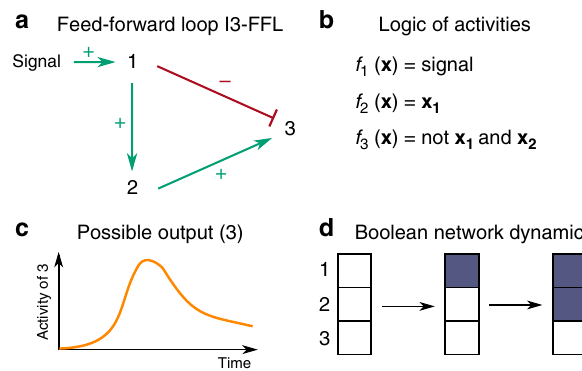
Fig. 1 Boolean modeling of the incoherent feed-forward loop of type 3 (I3-FFL). a the I3-FFL network and ( b ) its associated Boolean logic for nodes activities; f 1,2,3 ( x ) are the Boolean functions used to compute the next value of each node from a given con fi guration x of the network, which is here a binary vector specifying the current value of each node, x i referring to the Boolean value of node i . Whereas theoretical and experimental studies showed that starting from all nodes being inactive, an activation of the output is possible when the signal is turned on ( c ), BN analysis cannot predict this transient behavior: ( d ) shows the corresponding complete dynamics of f starting from the con fi guration where all nodes are inactive, and signal is set to 1. Con fi gurations are represented by piles of three squares, where the top square represents the state of the fi rst component, and so forth. A white square represents the inactive (0) state; a blue square represents the active (1) state; a dashed line indicates that no further evolution is possible. Arrows indicate possible transitions. The node 3 is never predicted to be